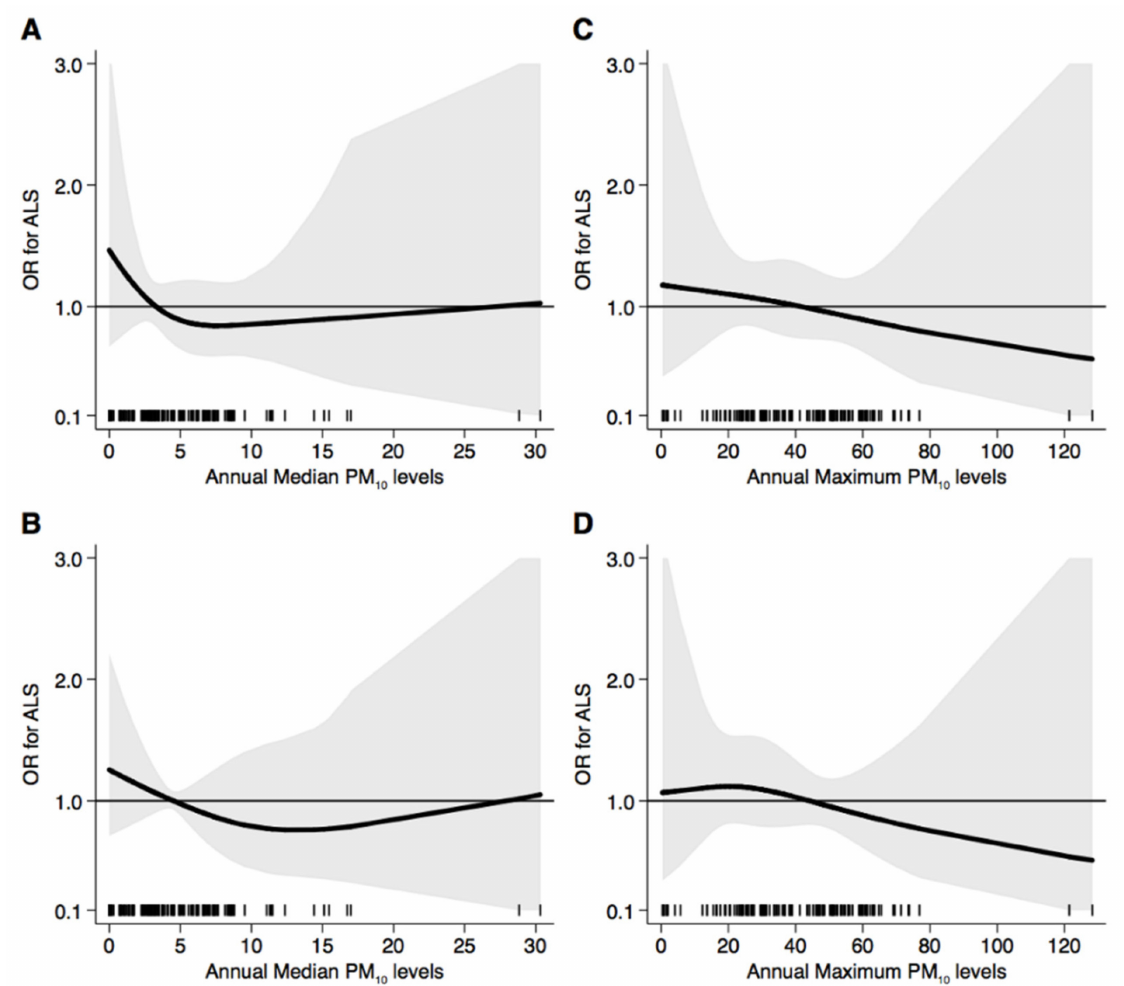
Figure 1. Spline regression analysis of amyotrophic lateral sclerosis (ALS) risk for increasing particulate matter (PM 10 ) exposure for both annual median and maximum levels using 10th, 50th, and 90th percentile distribution ( A , C ) or fixed categories (( B ): 5, 10 and 20 µ g/m 3 ; ( D ): 10, 20 and 50 µ g/m 3 ) as cutpoints. The black line indicates the odds ratio for ALS risk; the gray area indicates 95% confidence limits; the reference line is at 1.0; black spikes indicate the distribution of participant PM 10